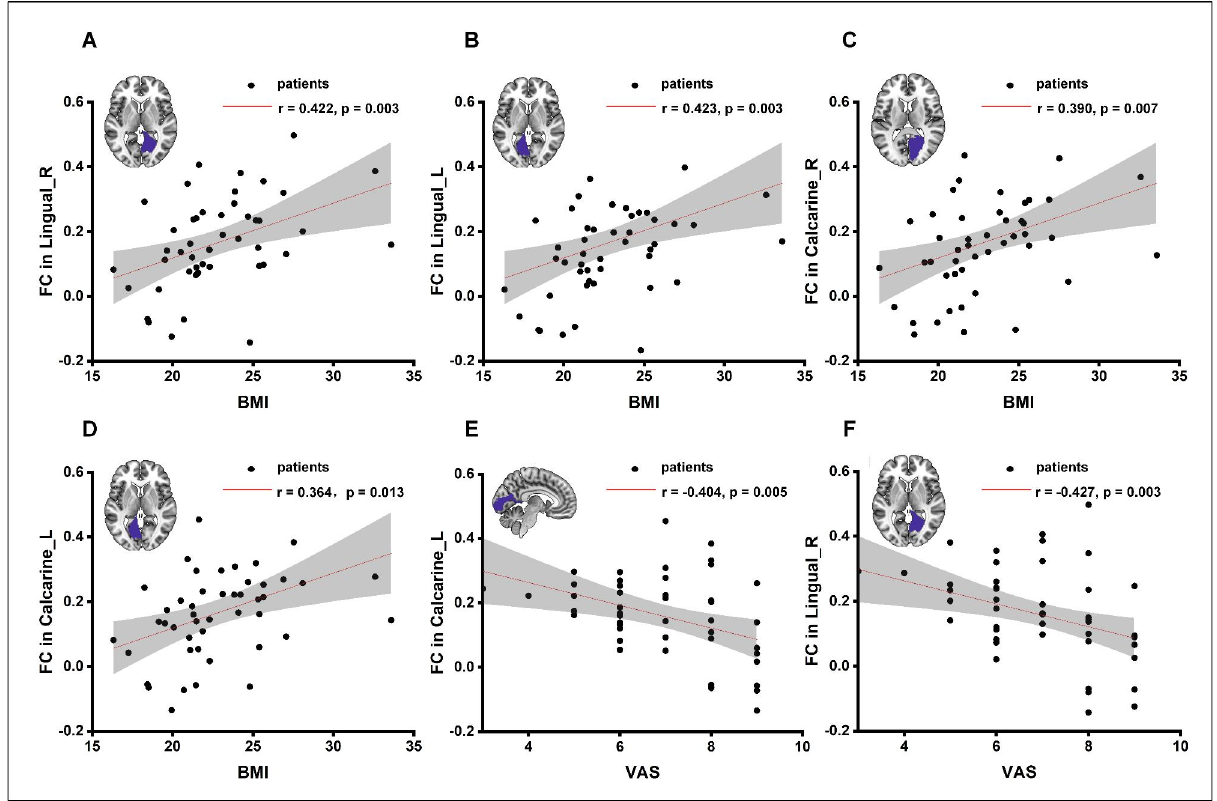
Fig. 4 Correlation between VAS scores, BMI, and FC of the right CN. BMI is positively correlated with FC values between the right CN and the (A) Lingual_R (according to the AAL atlas); (B) Lingual_L; (C) Calcarine_R; and (D) Calcarine_L. VAS scores are negatively correlated with FC values between the right CN and the (E) Calcarine_L and (F) Lingual_R. Note: The results shown are from two-tailed tests (p < 0.05) for the significance of Pearson’s cor- relation coefficient. AAL, automated anatomical labeling; VAS, visual analogue scale; BMI, body mass index; L, left; R, right; FC, functional connectivity; CN, caudate